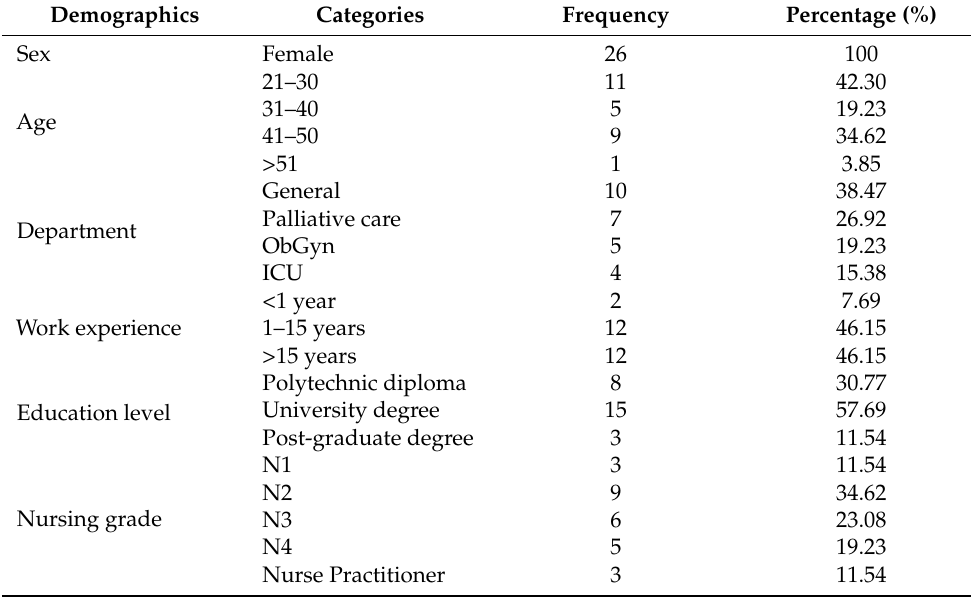
Table 2. Data of the participant information.